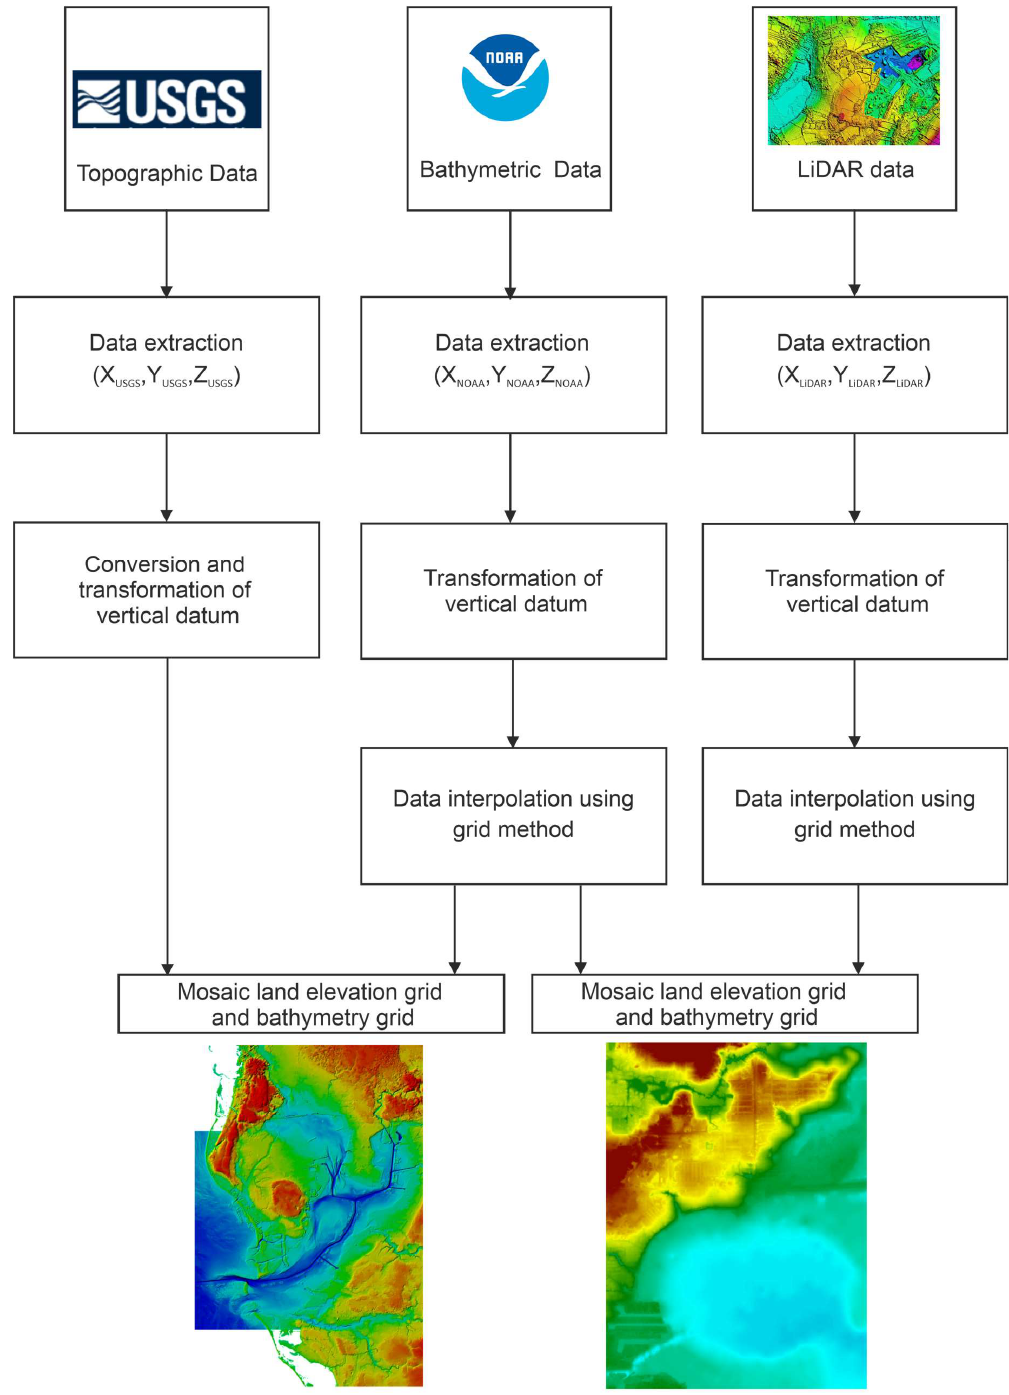
Figure 6 Figure 6. A simplified block diagram presenting the LiDAR, NOAA and USGS data integration according to [40]. A key component in the creation of a model is to prepare input data which must have a uniform reference system. The first stage of works commenced with the construction of an elevation database. To this end, the topographic data covering the bay area were extracted from the USGS National Elevation Dataset (NED). The NED comprised data derived from both optoelectronic measurements and topographic maps. They were converted to a horizontal reference North American Datum of 1983 (NAD 83) and the heights were expressed in relation to the North American Vertical Datum of 1988 (NAVD 88). Since the extracted topographic data were recorded in the target datum, the georeferencing